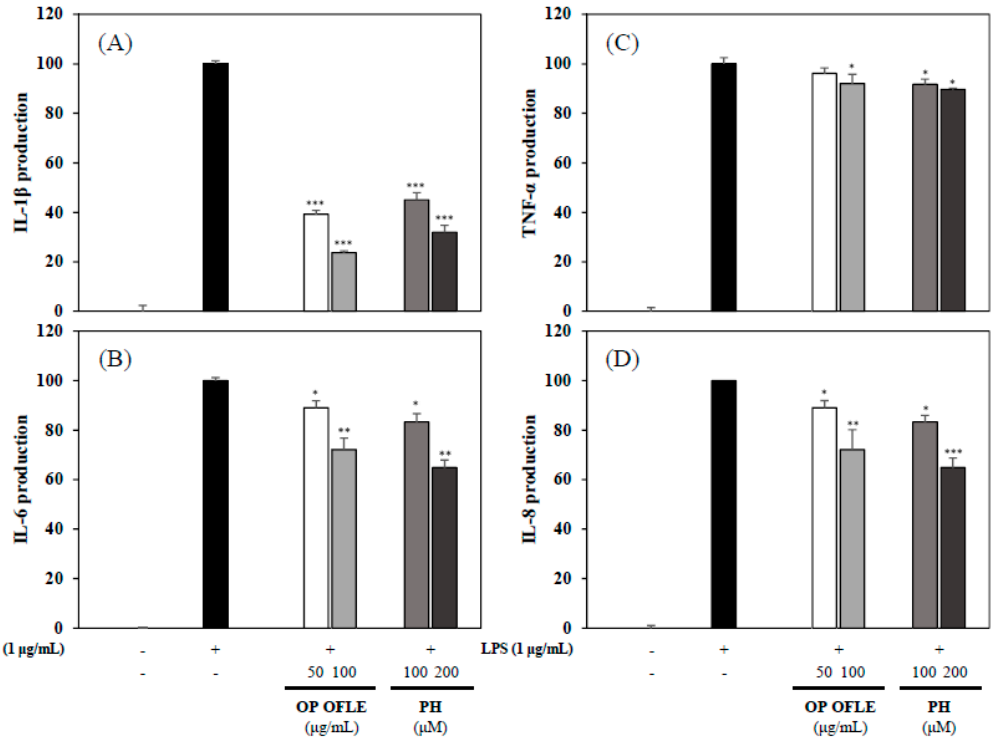
Figure 9. Effects of OP OFLE and PH on expression levels of IL-1 β , IL-6, TNF- α , and IL-8. Inhibitory effects of OP OFLE (50 and 100 μ g/mL) and PH (100 and 200 μ M) on IL-1 β ( A ), IL-6 ( B ), TNF- α ( C ), and IL-8 ( D ) expression levels in LPS-induced RAW 264.7 cell and HT-29 colonic epithelial cells were determined. These four proinflammatory cytokines were assessed with ELISA kits. Data are expressed as mean ± SD ( n = 3) of three individual experiments. * p < 0.05; ** p < 0.01; and *** p < 0.001 vs. LPS-stimulated group.